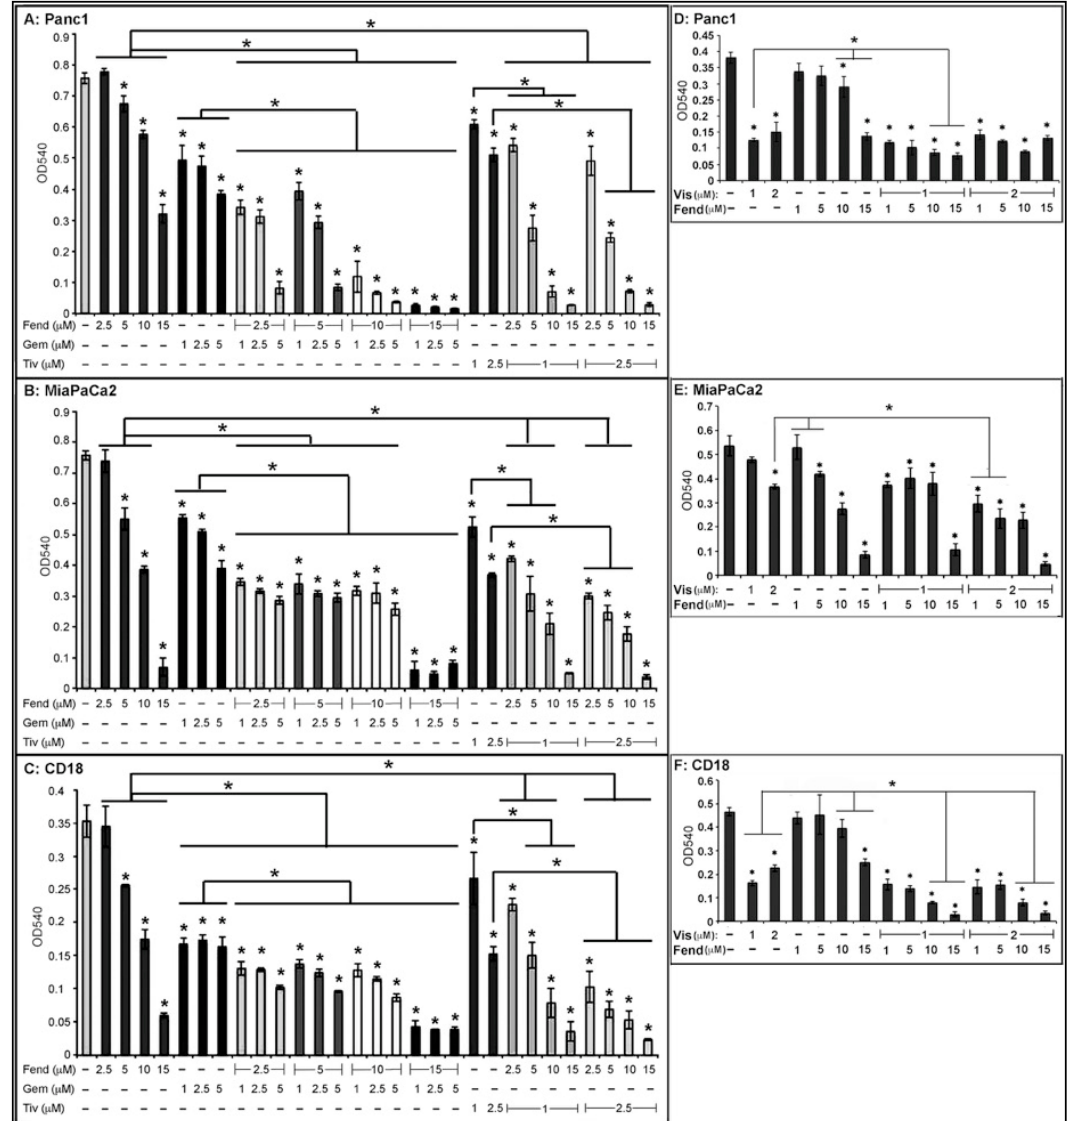
Figure 1. Fendiline significantly inhibits viability of PDAC cells when combined with visudyne, gemcitabine or tivantinib: Panc1 ( A , D ), MiaPaCa2 ( B , E ) or CD18 ( C , F ) cells were treated with indicated concentrations of fendiline (Fend: 1 µ M, 2.5 µ M, 5 µ M, 10 µ M and 15 µ M), gemcitabine (1 µ M, 2.5 µ M and 5 µ M), tivantinib (1 µ M and 2.5 µ M), or visudyne (1 µ M and 2 µ M), alone or in